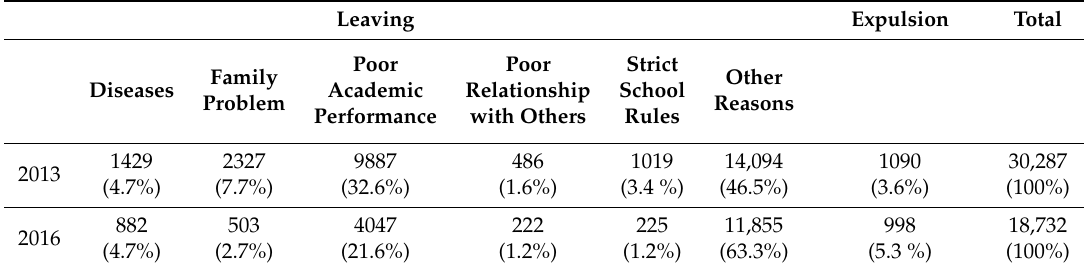
Table 2. The Reasons for high school dropouts in South Korea in 2013 and 2016. Leaving Expulsion